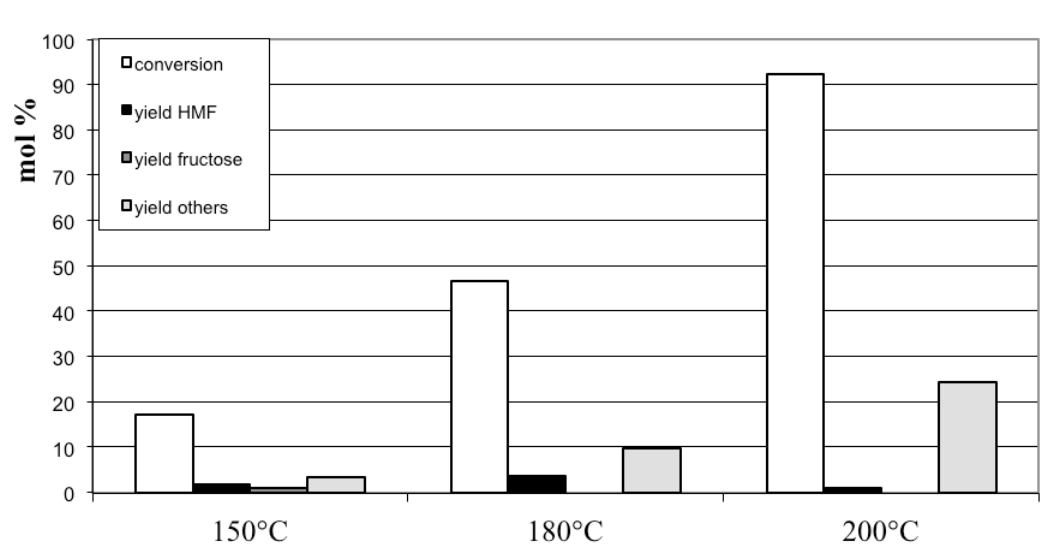
Figure 2. Glucose conversion in aqueous media: temperature and pH dependences. 1 a. Glucose conversion in acidic aqueous media (pH = 1, HCl) at 150 °C, 180 °C and 200 °C.